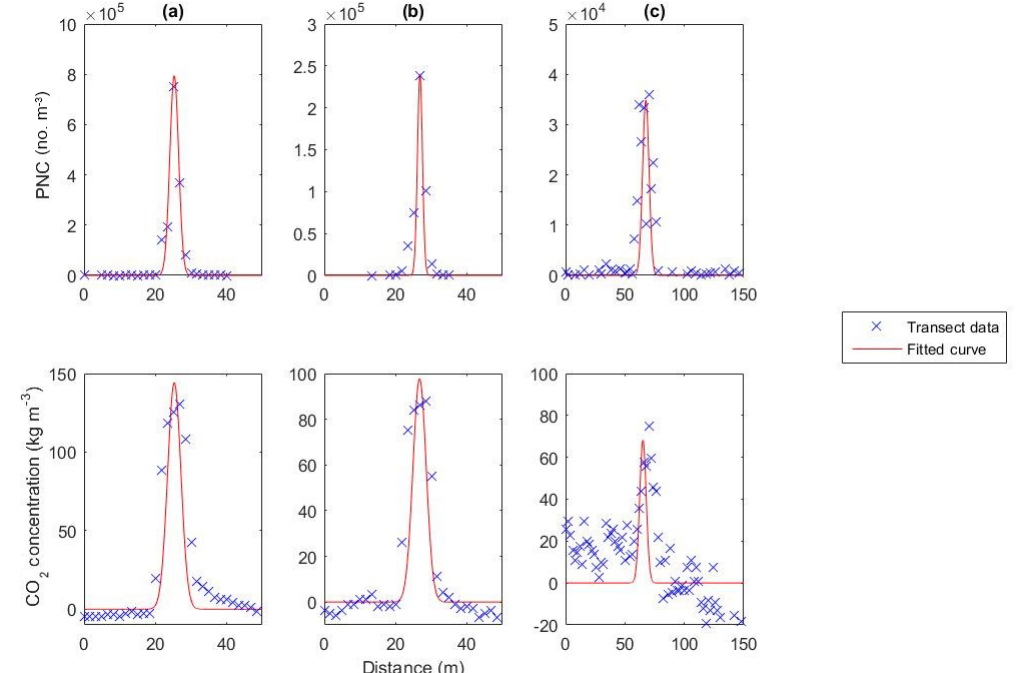
Figure 4. Panels (a) and (b) show the measured PN and CO 2 concentration profiles and fitted Gaussian curves for two different transects 20m behind the ship, 25m above the surface during day 2. Panel (c) shows the PN and CO 2 concentration profiles and fitted Gaussian curves collected during flight 3 of day 1 100m behind the ship, 25m above the